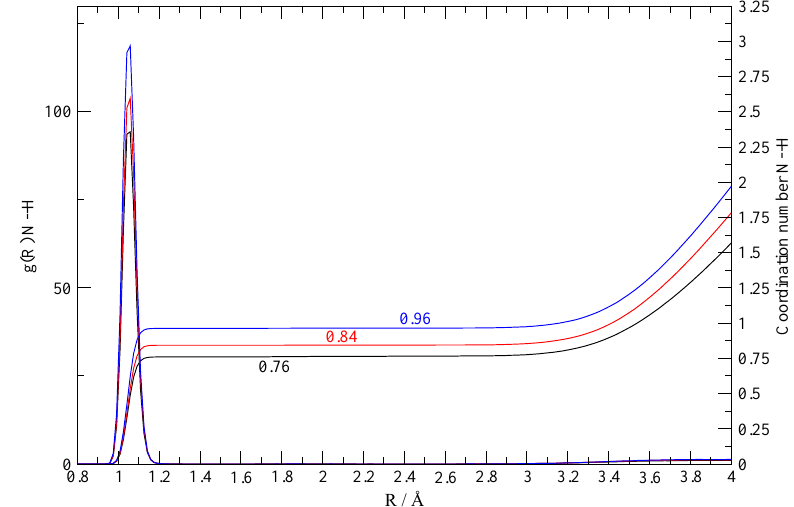
Figure 9. N–H g(r) in the 8:2 simulation and relative volumetric integral (that is, the coordination number) for different sampling intervals. The black lines are obtained by sampling the entire trajectory (950 ps), the red one by sampling the second half (475 ps), and the blue one by sampling the last third (320 ps).